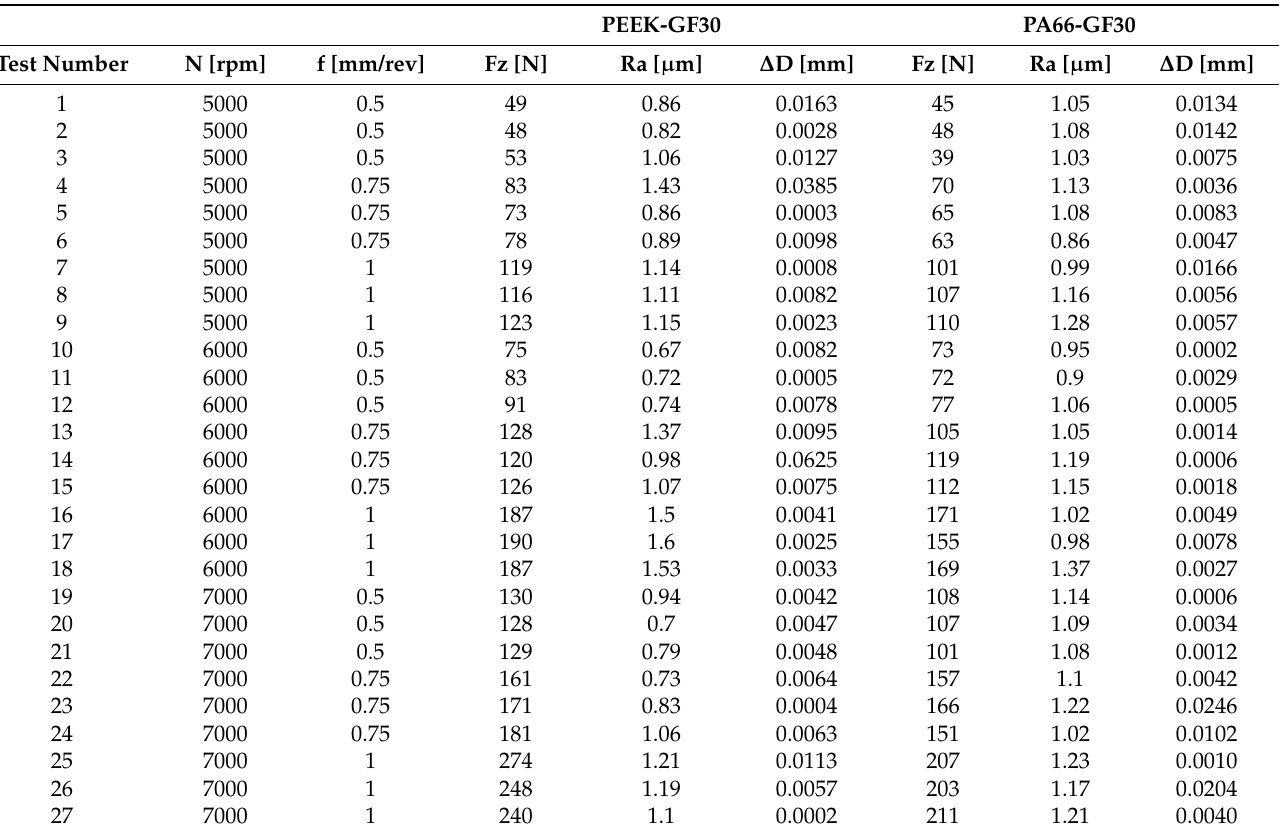
Table 3. Experimental results for PEEK-GF30 and PA66-GF30 with respect to thrust forces, average roughness, and diameter